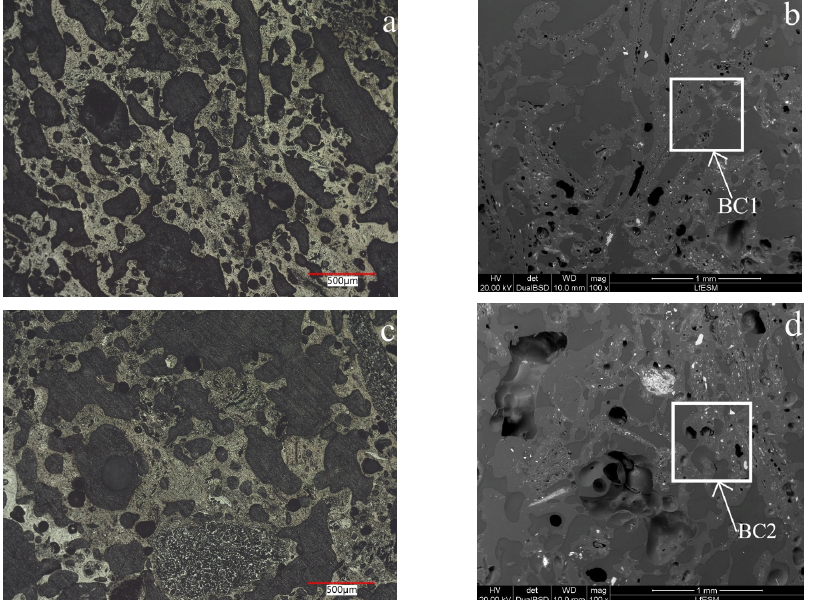
Figure 5. Microscopic images of the biocoke samples. ( a ) Optical image of the biocoke1 sample, magnification 100 × . ( b ) SEM image of the biocoke1 sample with a spot of the EDS spectrum (BC1), magnification 100 × . ( c ) Optical image of the biocoke2 sample, magnification 100 × . ( d ) SEM image of the biocoke2 sample with a spot of the EDS spectrum (BC2), magnification 100 × . The arrow indicates the spot for which the EDS was applicable. Table 5. The SEM/EDS analysis results for the carbon-bearing sources. Chemical Composition,